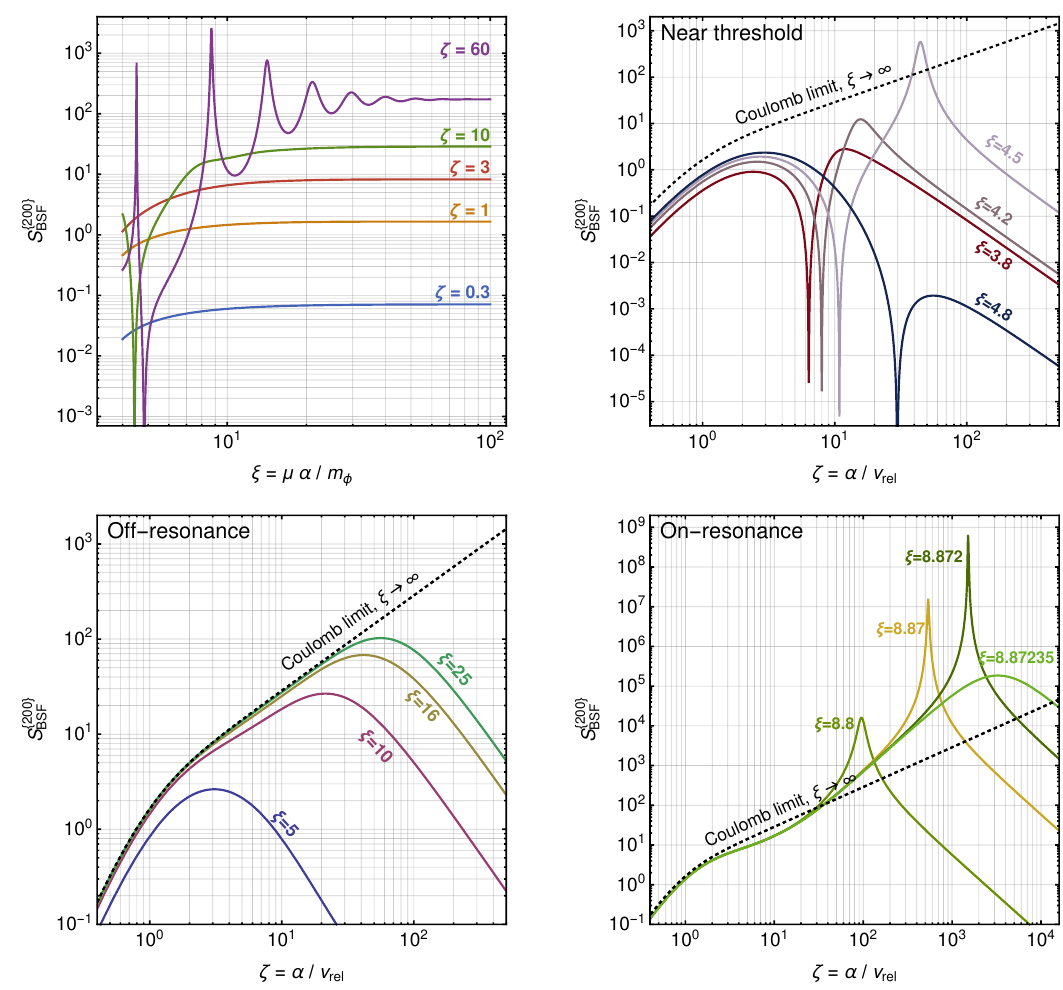
Figure 4 . Resonance structure and velocity dependence of the S f 200 g